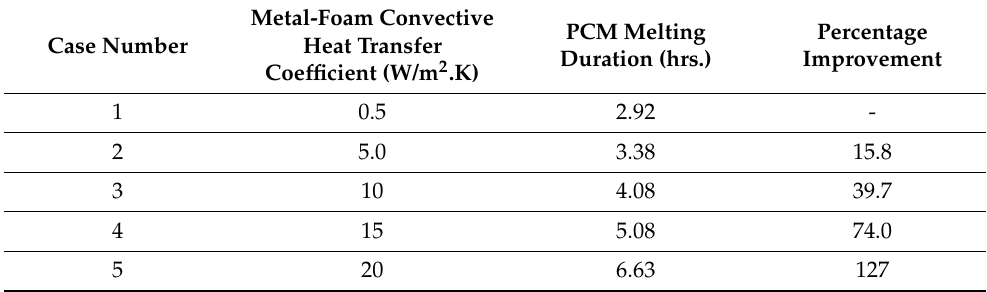
Figure 7. PCMheattransfercoefficients’profilesfordifferentmetalfoamconvectiveheattransfercoefficients. Figure 7. PCM heat transfer coefficients’ profiles for different metal foam convective heat transfer coefficients. Table 3. Table 3. Improvement of PCM melting duration for different metal foam convective heat transfer coefficients.